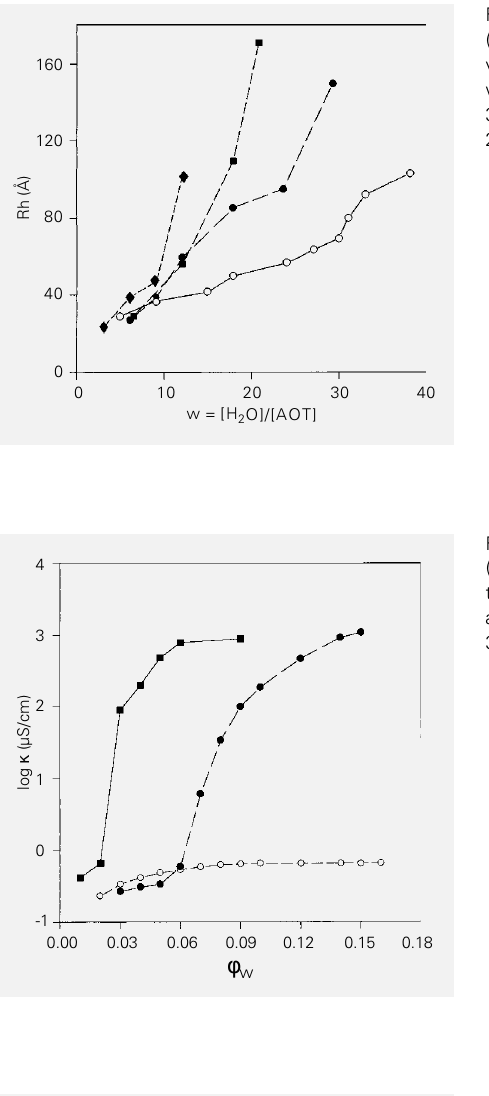
Figure 4 - Electric conductance ( k ) as a function of temperature. [Urea] = 5 M. f w = 0.02 ( ! ); 0.03 ( l ); 0.04 ( • ); 0.076 ( (cid:224) ); 0.1 ( ¢ ); 0.2 ( P ). w =